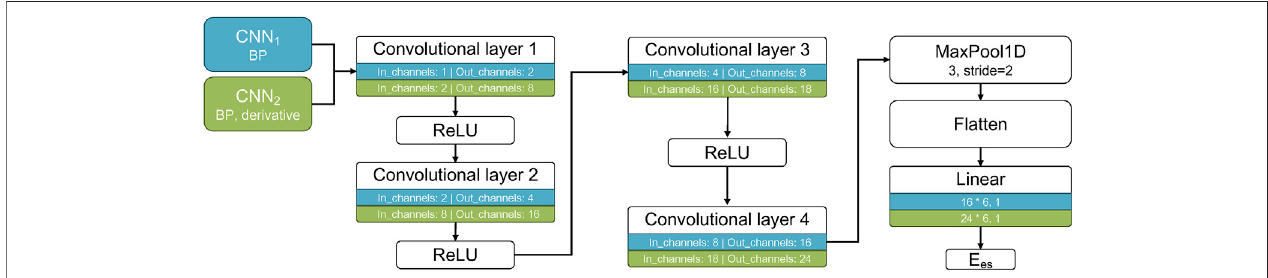
FIGURE 2 | Architecture of the CNN models. The two CNN models are shown in different colors with their respective inputs listed, as well as the number of in_channels and out_channels for each convolutional layer and the output E es .